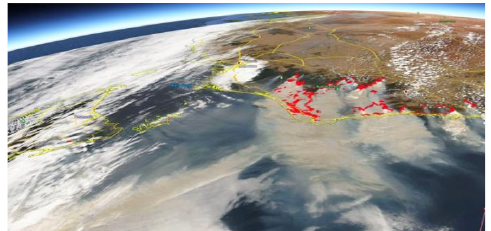
Figure 1: Smoke rising from fires on the east coast of Australia, red shows live fire (Vernier and Reed 2020). Climate condition, topographic features, fuel/vegetation condition and its accumulation are the factors that contribute to bushfire behaviour (Gould and Cruz 2012). Increasing climate to change abruptly, making hot days hotter. Resulting